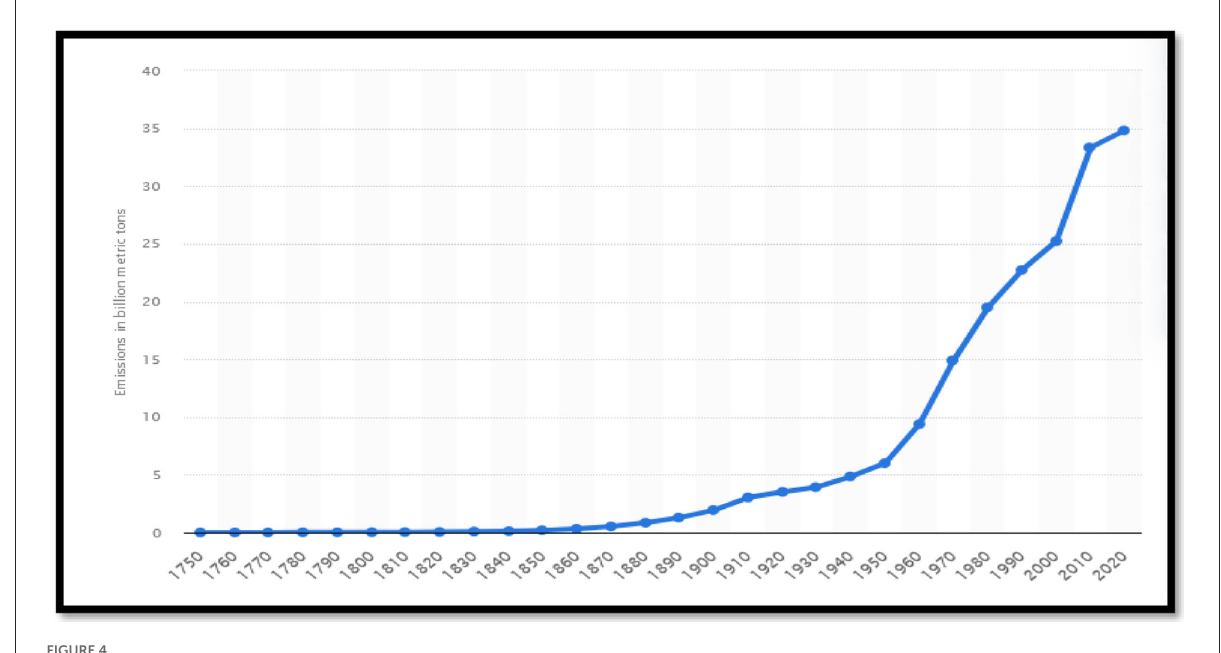
FIGURE4 Historical CO 2 emissions from global fossil fuel combustion and industrial processes from 1750 to 2020. Source: Author’s analysis, Statista (2022b)